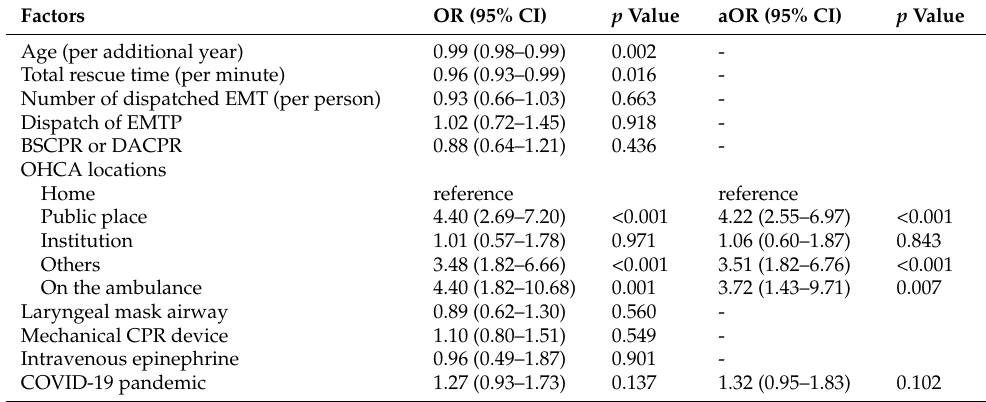
Table 3. Predictive factors of accomplishing continued ROSC ≥ 24 h.